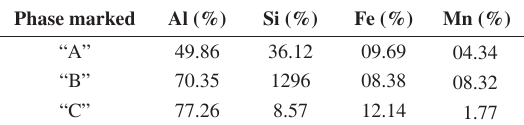
Table 2. Energy spectra of intermetallic compounds in CS cast A1 and A2